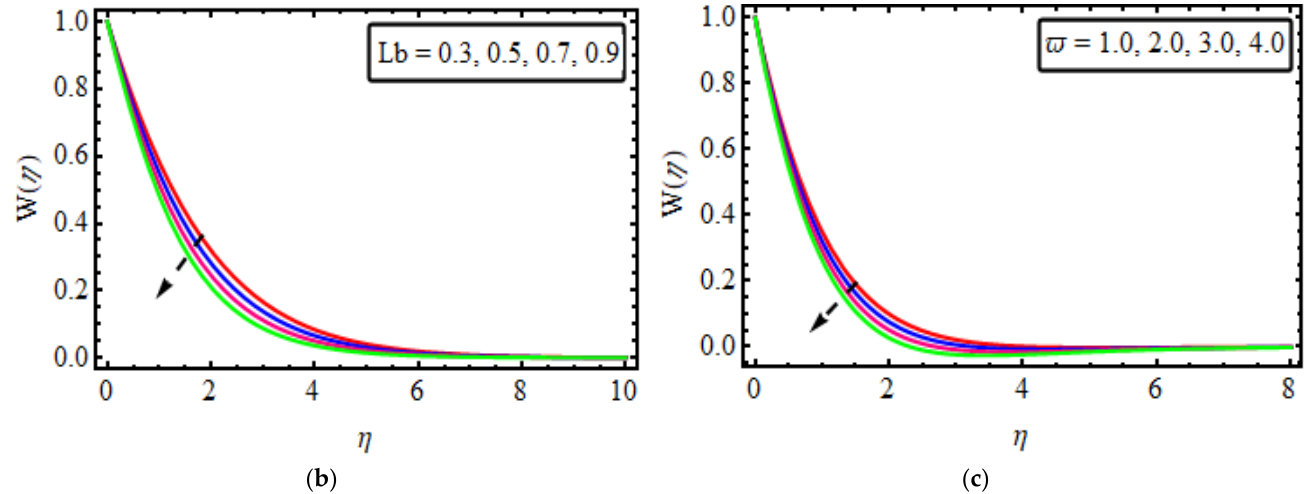
Figure 6. ( a – c ) The impact of φ ( η ) numerous variables ( a ) Nb ( b ) Nb ( c ) Cr ( d ) Sc .